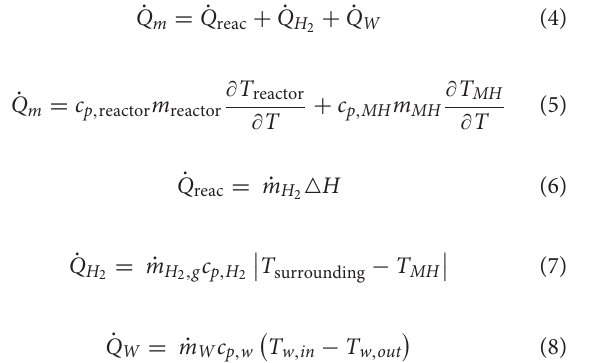
( Figure 9A–i ; Wakao and Vortmeyer, 1971). At intermediate pressures of 0.02–3 MPa, the effective thermal conductivity of typical MH evolves into an S-shaped curve. To isolate the heat generated under the influence of gas pressure built-up, helium gas can be used because of its inertness toward the hydride forming metal and a thermal conductivity close to that of